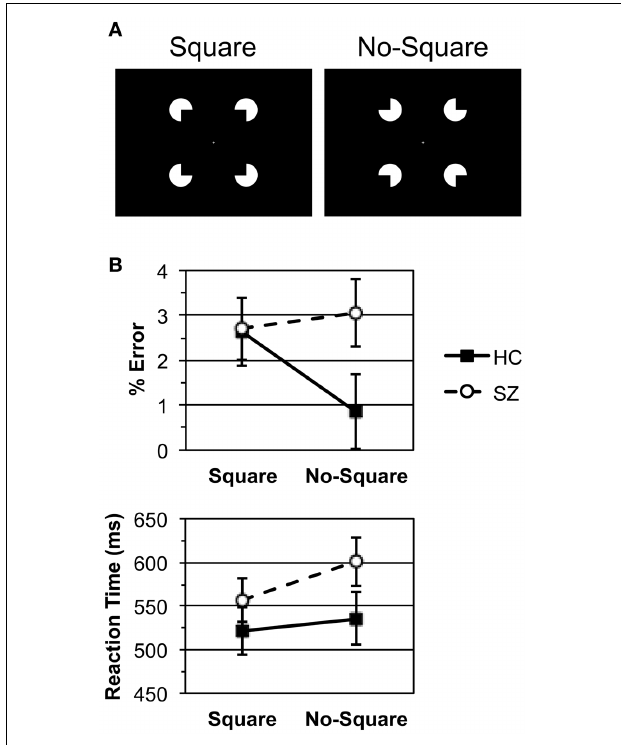
FIGURE 1 | (A) The Kanisza Square and No-Square stimuli. (B) Error rate and median reaction time data for the healthy control (HC) and schizophrenia patient (SZ) groups. Bars indicate standard